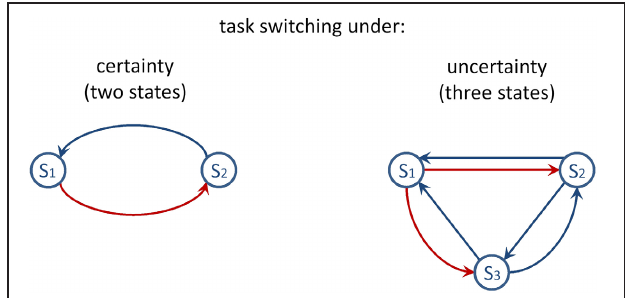
FIGURE 1 | Task-switching paradigms considered as dynamic environments which involve frequent state transitions. Left panel: The simple diagram shows state transitions when two tasks are viable. The red arrow indicates that S1 passes on to S2 (i.e., switching between task sets consists of a one-alternative choice). The blue arrow illustrates the alternative switch between task sets. Right panel: The diagram shows state transitions when three tasks are viable. The red arrows indicate that S1 passes on to S2 or to S3 (i.e., switching between task sets consists of a two-alternative choice). The blue arrows illustrate possible other task